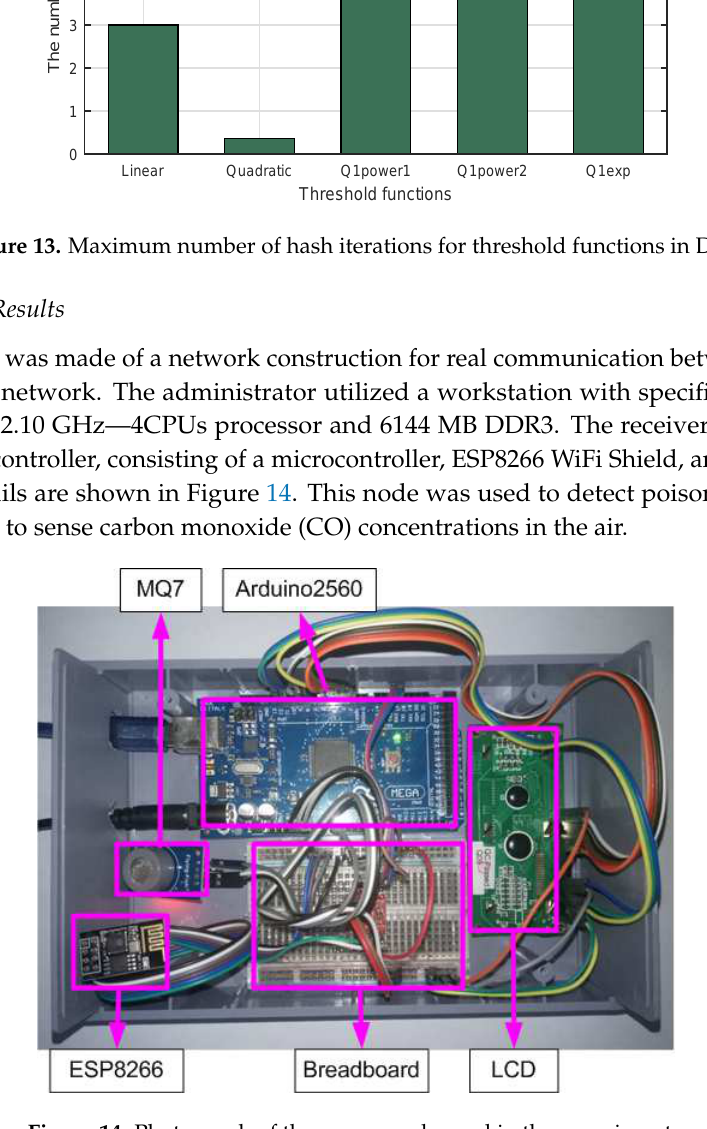
Figure 14. Photograph of the sensor node used in the